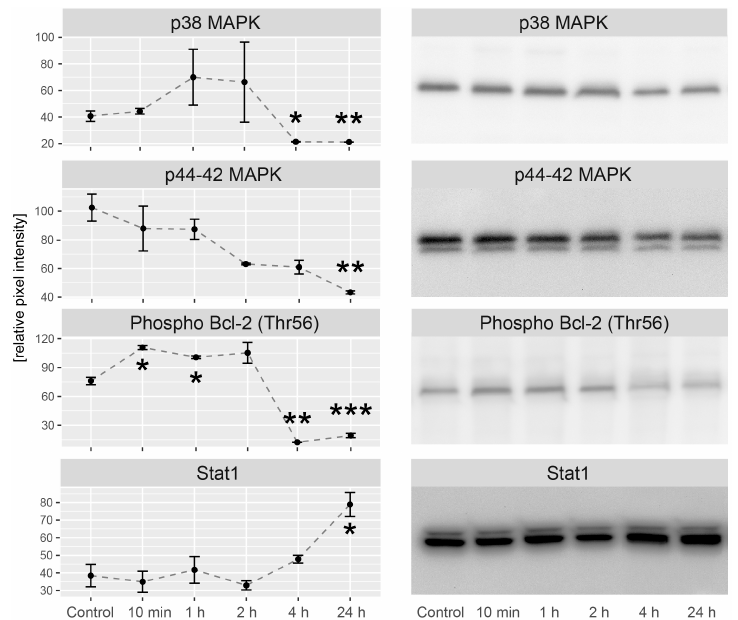
Figure 9. Densitometric analysis includes several key factors of signaling pathways involved in apoptosis, proliferation in different time after the treatment with LEP. Graphs represent protein expression relative to glyceraldehyde-3-phosphate dehydrogenase (GAPDH) levels. Representative experiments of proteins immunoblotting were also shown. Results are presented as means ± SEM, n = 3. Statistical comparison by Student’s t-test: * p <0.05, ** p <0.01, *** p <0.001.